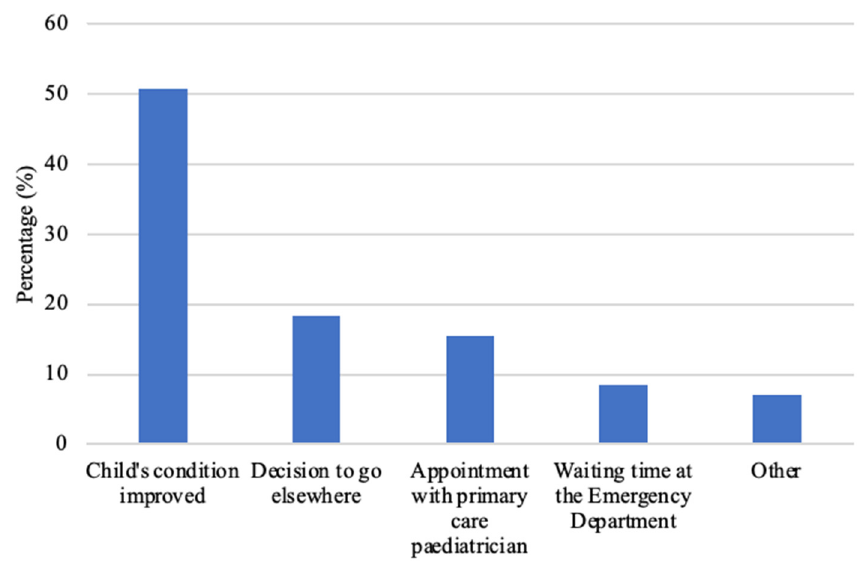
Figure 3. Parental reasons for non-adherence, expressed in percentage (%, n =